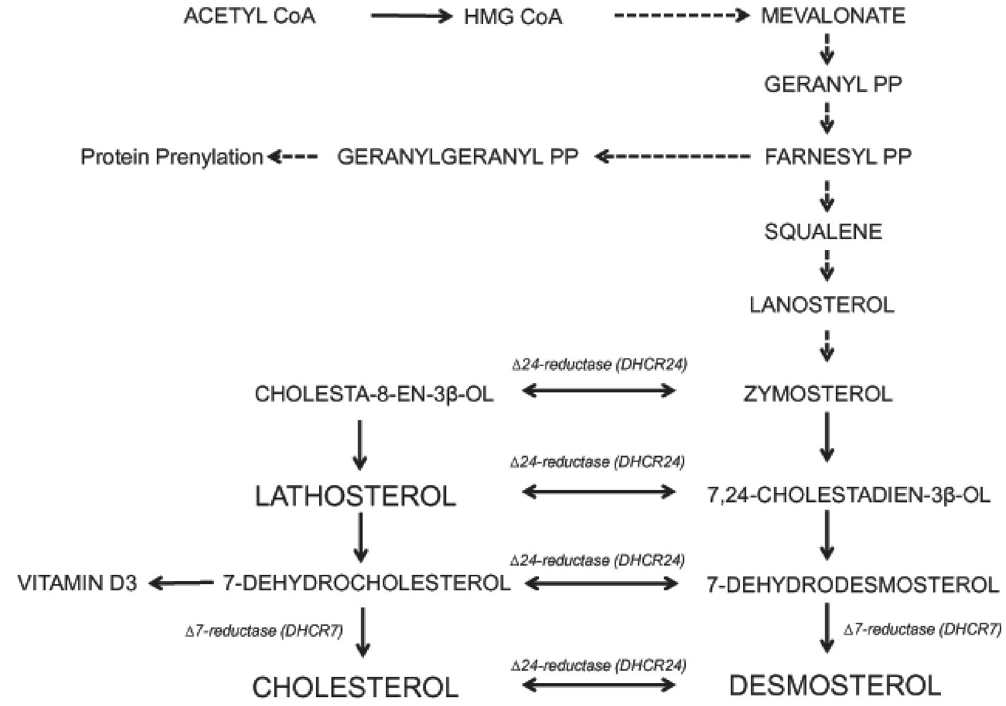
Figure 1. Schematic of the endogenous cholesterol biosynthetic pathway. Cholesterol synthesis involves a complex series of enzymatic reactions from the 2 carbon acetyl CoA to 27 carbon cholesterol. De novo cholesterol biosynthesis takes place in the ER membrane, also the site of HCV replication. The rate limiting step is the activity of 3-hydroxy-3-methylglutaryl (HMG) CoA reductase and the production of mevalonate. The post mevalonate intermediate geranylgeranyl is required for HCV replication. Geranyl that is not used in prenylation is converted to farnesyl and subsequently to squalene, then to lanosterol 18 . From lanosterol, cholesterol biosynthesis can proceed by two routes: via a desmosterol intermediate (Bloch pathway), or via a lathosterol intermediate (Kandutsch-Russel pathway), with flux across the two pathways regulated by ∆24 dehydrocholesterol reductase